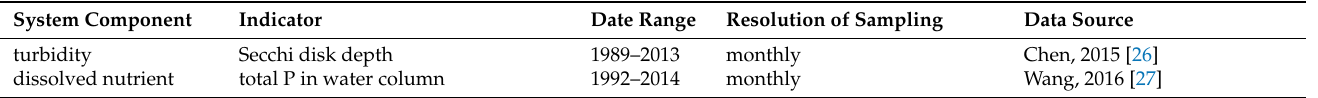
Table 1. Indicator data for different lake system components with time-series date